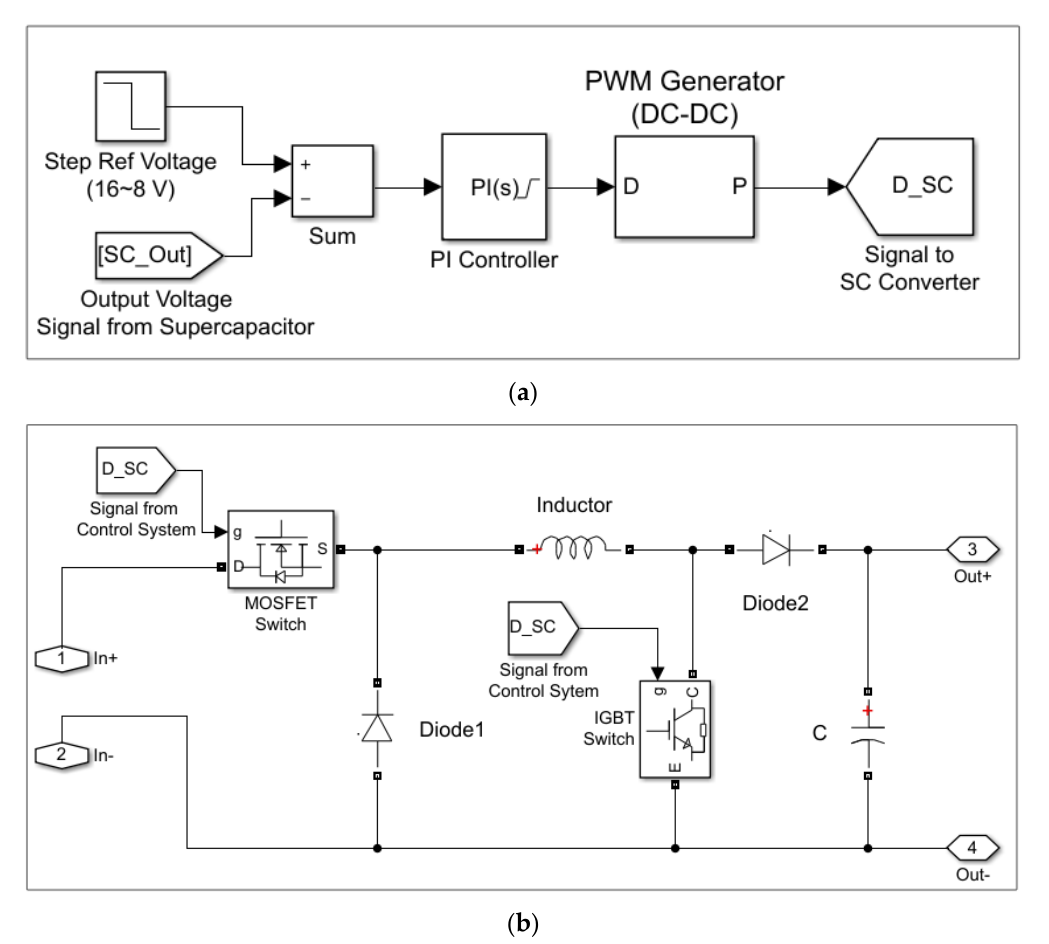
Figure 12. One ‐ directional PI power management system for supercapacitor ( a ) control system and ( b ) converter system. ( b ) converter